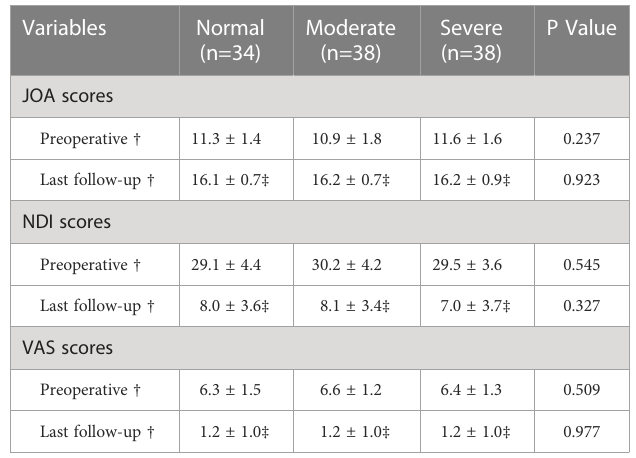
TABLE 2 Clinical